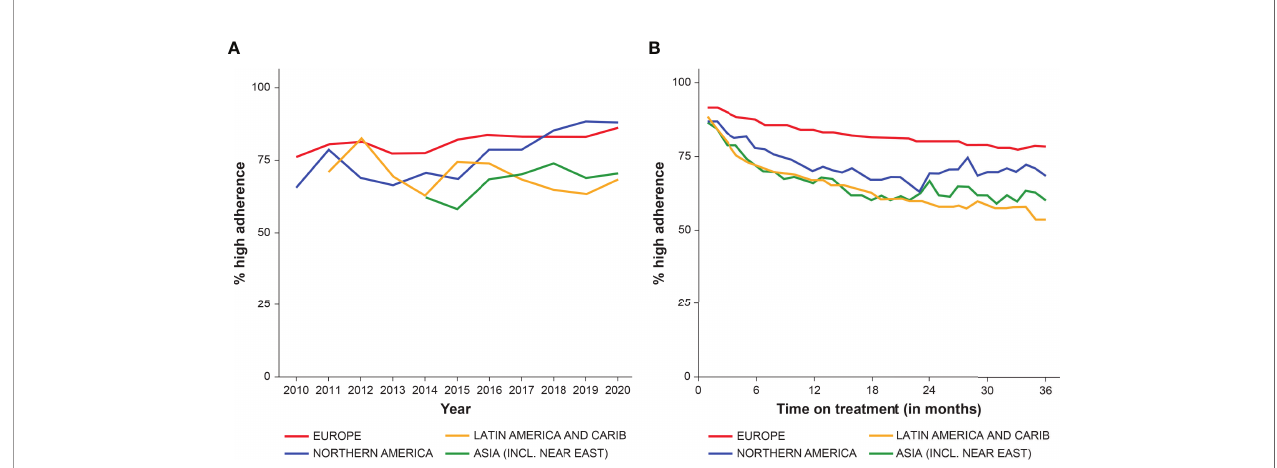
FIGURE 5 | The proportion of patients with high adherence ( ≥ 85%) from 2010 to end of 2020, strati fi ed by region, by year (A) , and between 0 – 36 months of GH therapy (B)